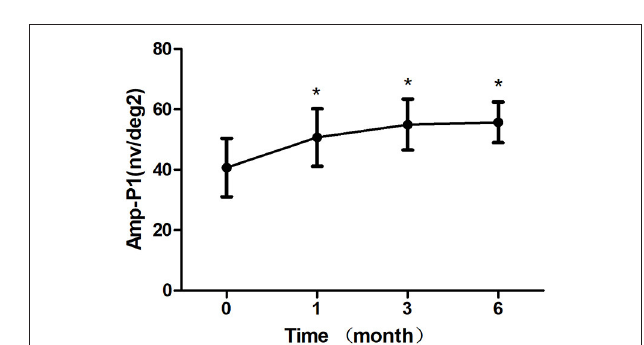
FIGURE 5 | Mean change in amplitude response density in ring 1 of mfERG amplitude (Amp-P1) over 6 months. The significant improvements in Amp-P1 were observed at each follow-up visit compared with baseline values (* P < 0.05). Error bar represents standard